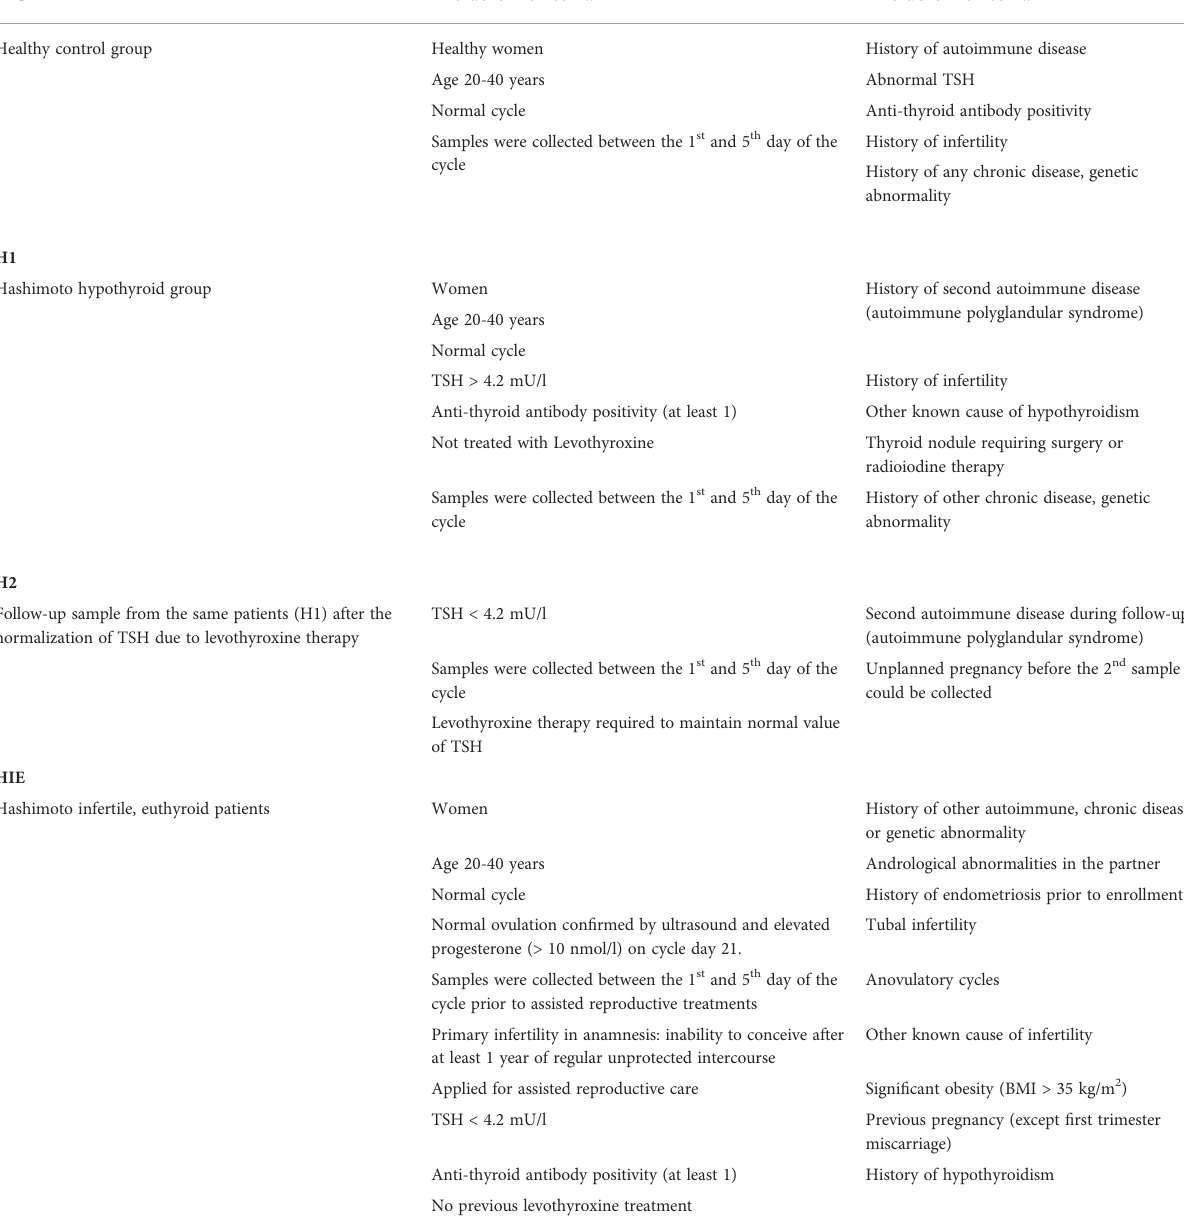
TABLE 1 Clinical inclusion and exclusion criteria for patient